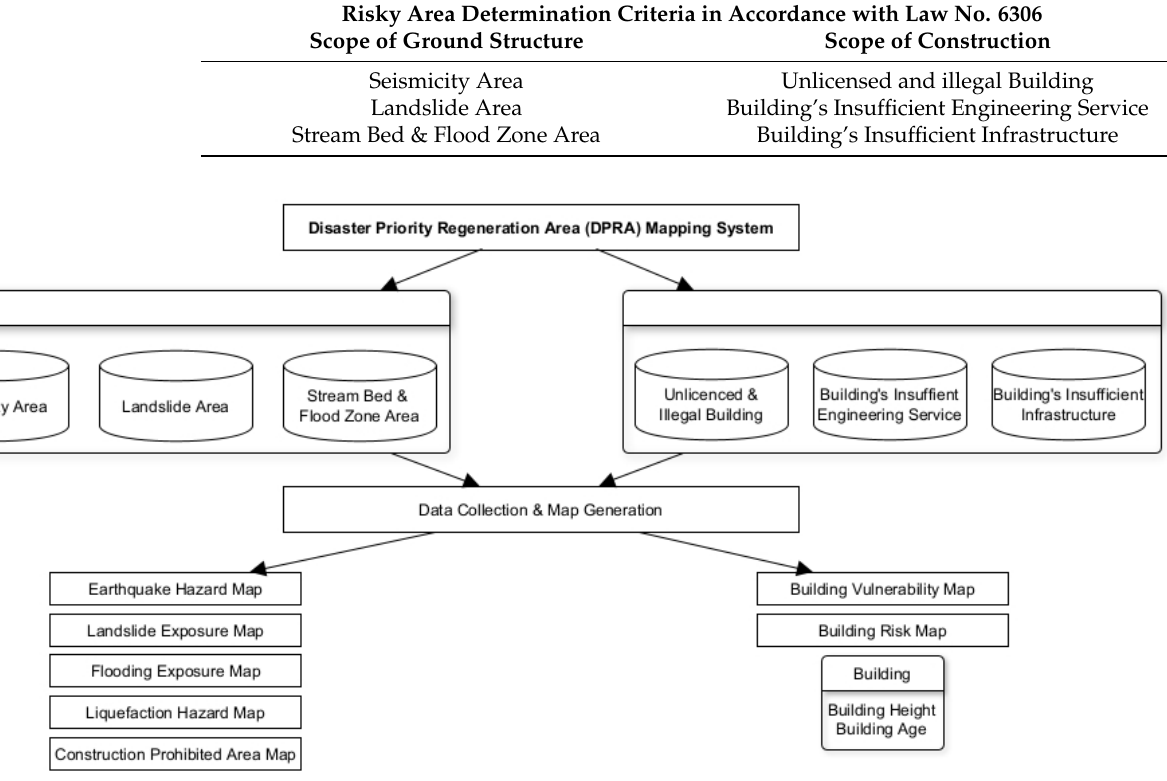
Table 1. Risky Area Determination Criteria In Accordance With Law No. 6306. Risky Area Determination Criteria in Accordance with Law No. 6306